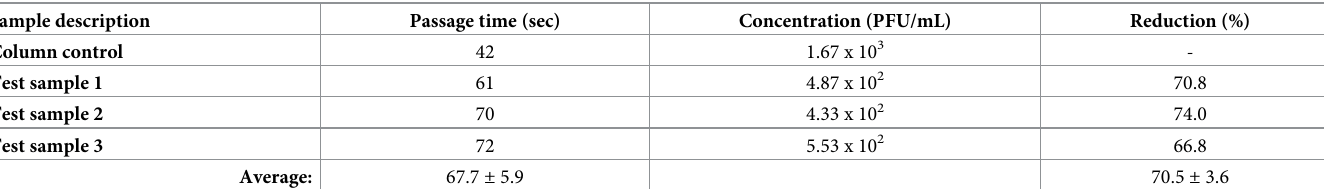
Table 7. NR-55654: Isolate hCoV-19/Peru/un-CDC-2-4069945/2021 (Lineage C.37; Lambda